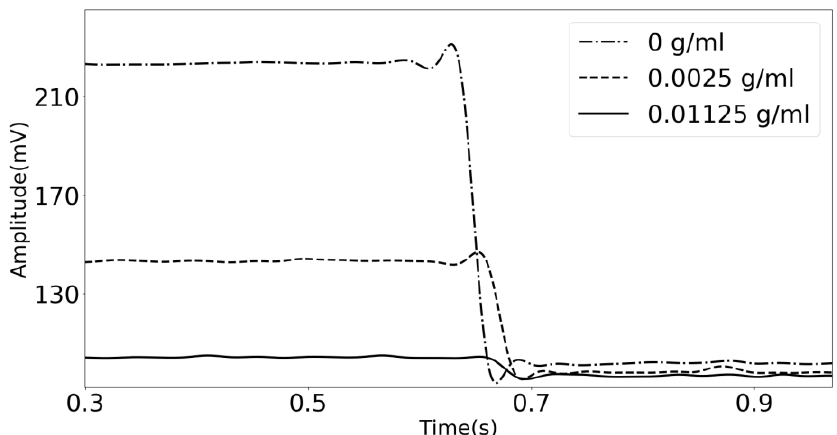
Figure 6. Transient time experimental results of the phononic crystal sensor using distilled water (dashed and dotted line), and lithium carbonate solutions with a concentration of 0.01125 g/mL (solid line) and 0.0025 g/mL (dashed line).